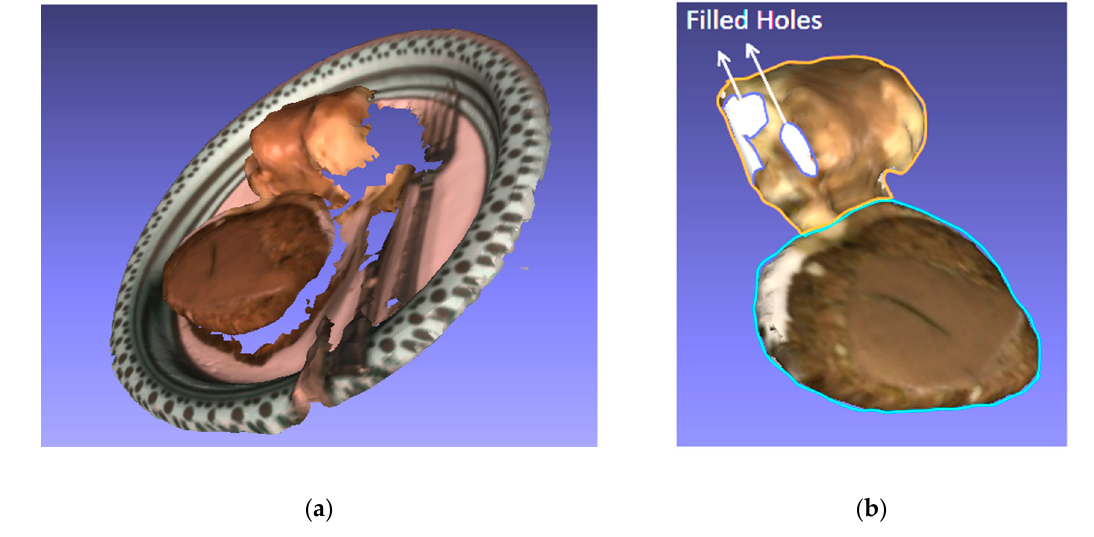
Figure 11. Example of a captured surface mesh of a plate of meatloaf and mashed potatoes: ( a ) shows the initial scan before preprocessing, including the meal, utensils, and plate; ( b ) shows the segmented scan with the plate and utensils removed and hole closing performed. The perimeter of each segment is highlighted (meatloaf in blue, mashed potatoes in orange).